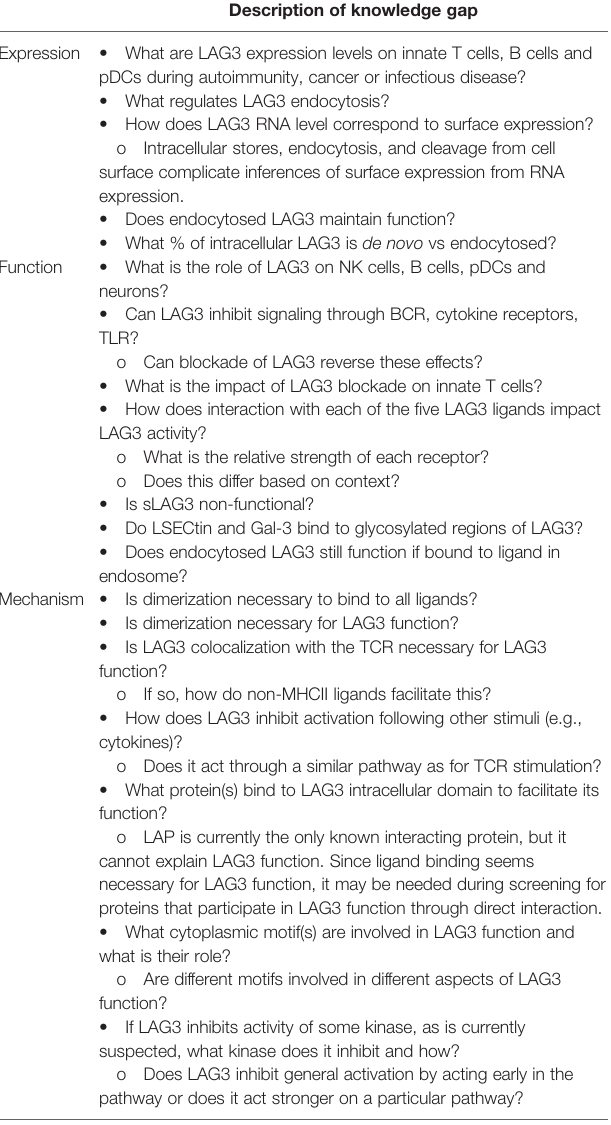
TABLE 1 | Unknowns of LAG3 Biology. Description of knowledge